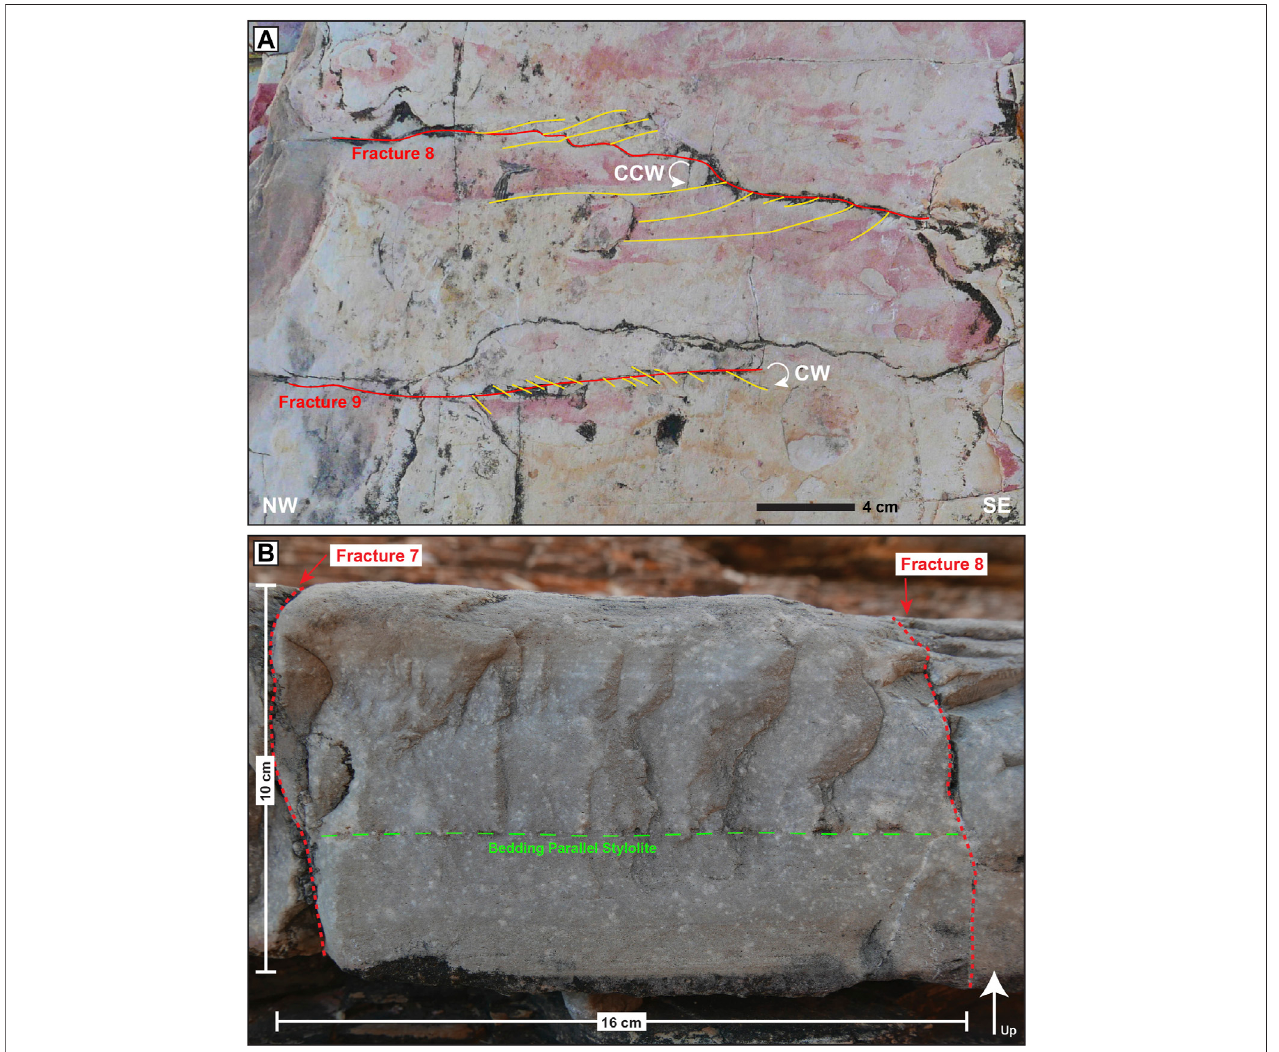
FIGURE 9 | (A) Map-view photograph of Pavement 2, Fractures 8 & 9, traced in red. Twist hackles (traced in yellow) can be seen rotating counter-clockwise on Fracture 8, and clockwise on Fracture 9. (B) Pro fi le-view photograph of a perpendicular joint in Pavement 2, located between Fractures 7 and 8, traced in red. Twist hackles can be seen emanating upward from a bed-parallel stylolite, located 6 cm from the top of the bed and traced in green.